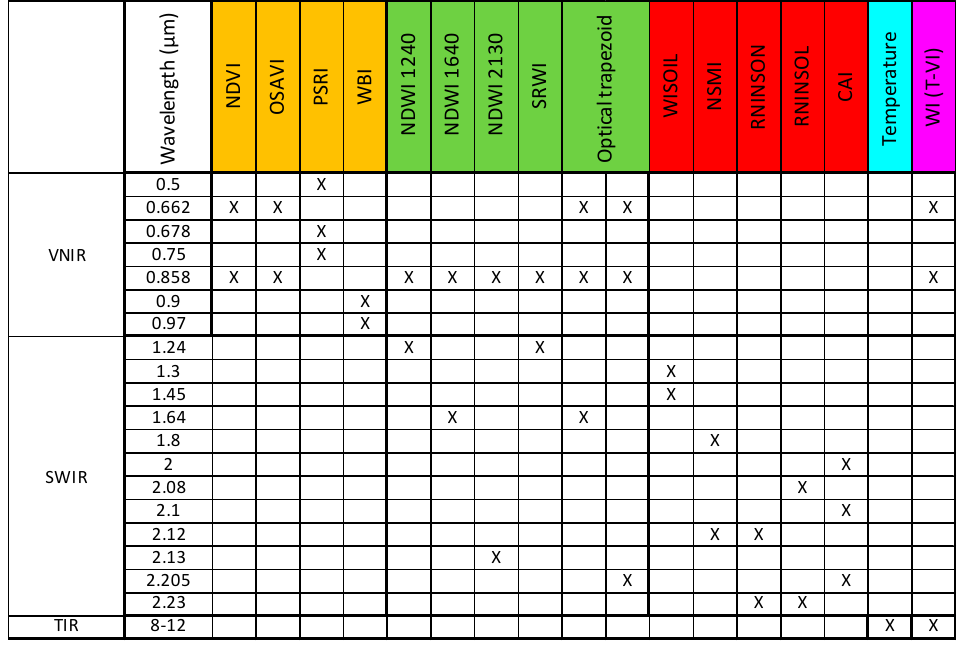
Figure 3. Considered spectral bands, spectral indexes and multiwavelength methods. The combinations involving wavelengths in the visible to NIR range are in orange, those with wavelengths from the visible to SWIR range are in green, those with wavelengths in the SWIR range only are in red, and the T-VI method is in purple. The use of the thermal infrared signal alone was considered as well (blue case).